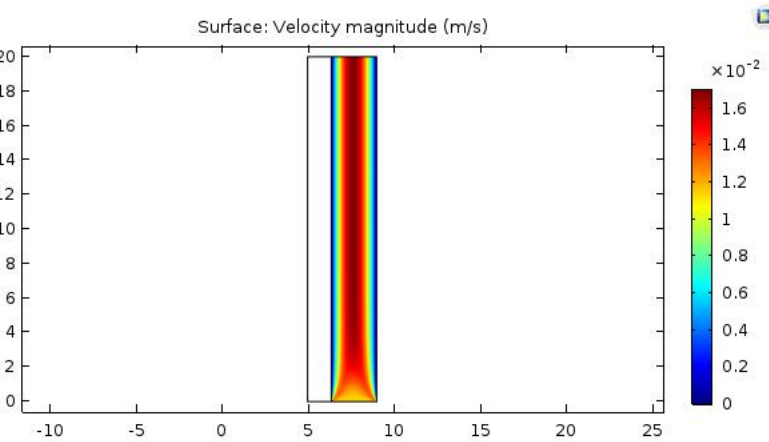
Fig. 14 Velocity profile (60 °C temperature, 3 l/min feed flow rate and 1 bar pressure)